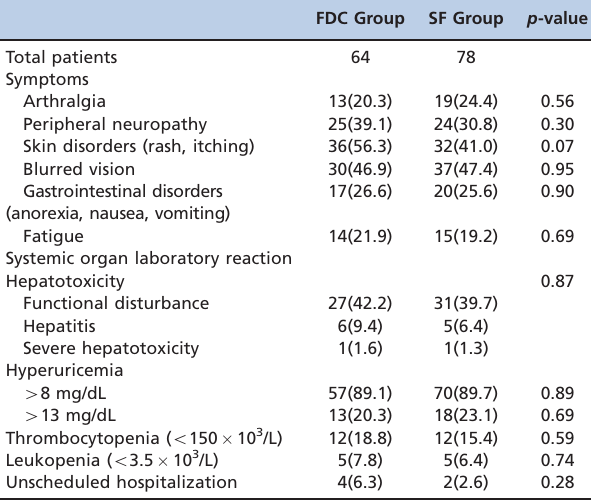
Table 2 - Adverse effects in the patients evaluable for safety